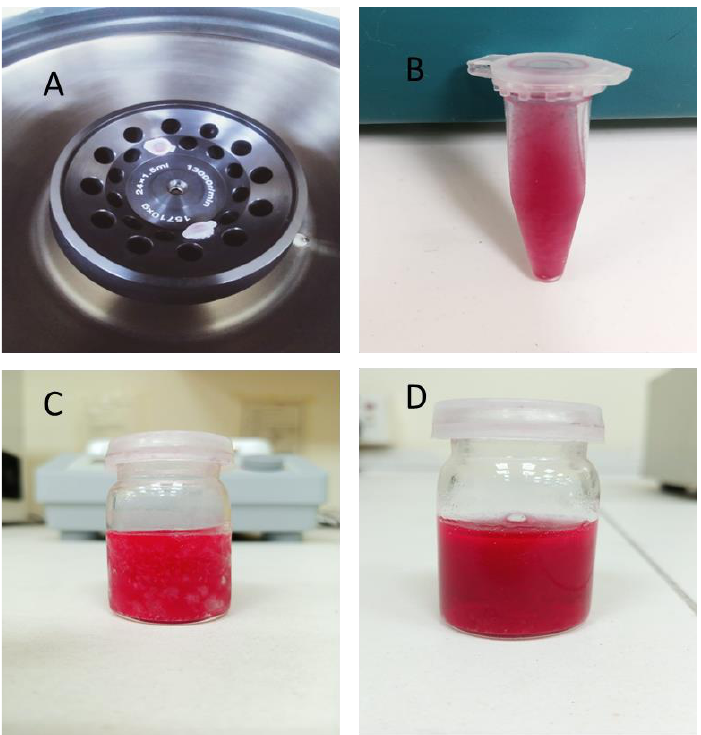
Figure 5. Stability of the F1 formulation both after centrifugation ( A , B ) and with freeze – thaw ( C , D ) methods.